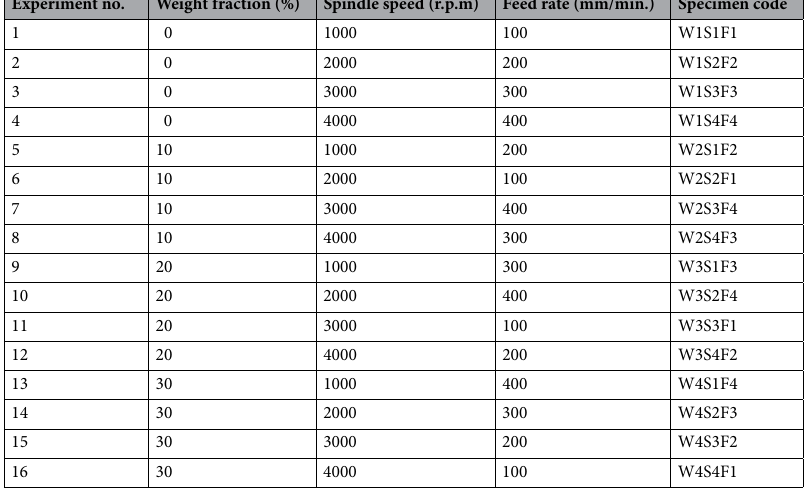
Table 5. Taguchi L16 orthogonal array for drilled PP and GFR/PP under different drilling